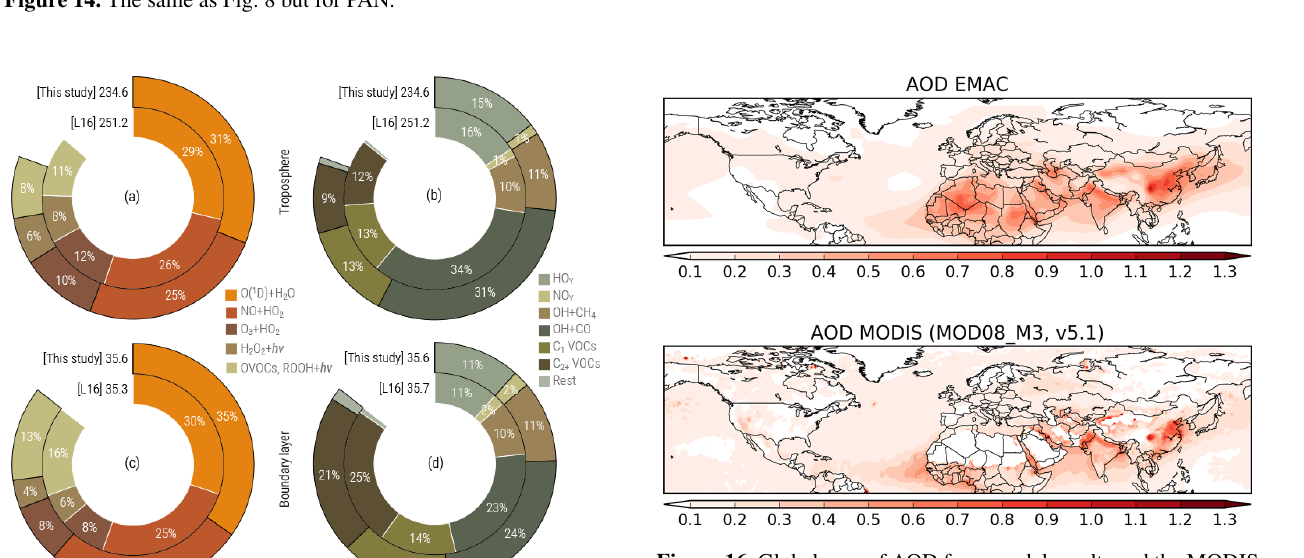
Figure 14. The same as Fig. 8 but for PAN.